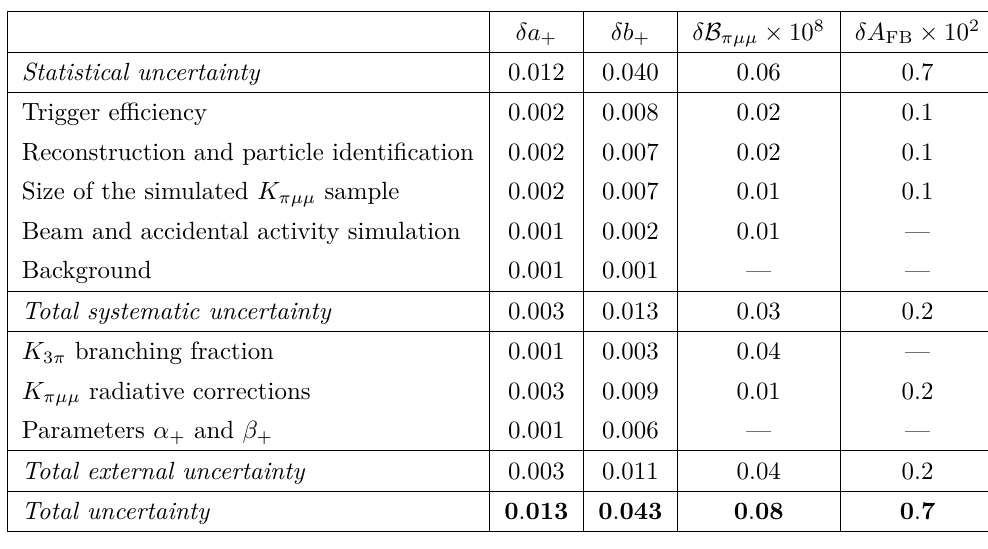
Table 1 . Summary of